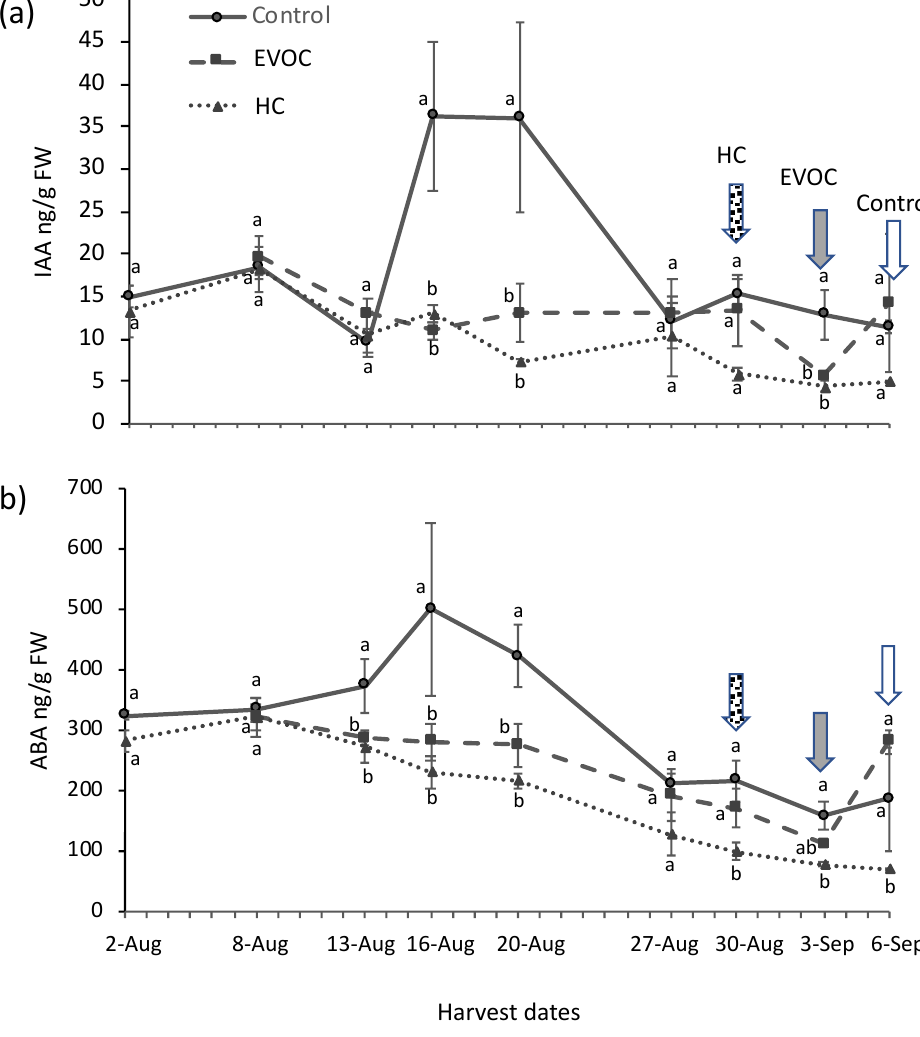
Figure 4. ( a ) Indole-3-acetic acid (IAA) and ( b ) abscisic acid (ABA) concentration (ng/g FW) over time in floral buds treated with dormancy breakers hydrogen cyanamide (HC) and emulsified vegetable oil compound (EVOC) compared to control; arrows indicate the date that buds reached bud burst (stage 5). Values are mean ± s.e. ( n = 4), at each time point values with different letters are significantly different ( p < 0.05).